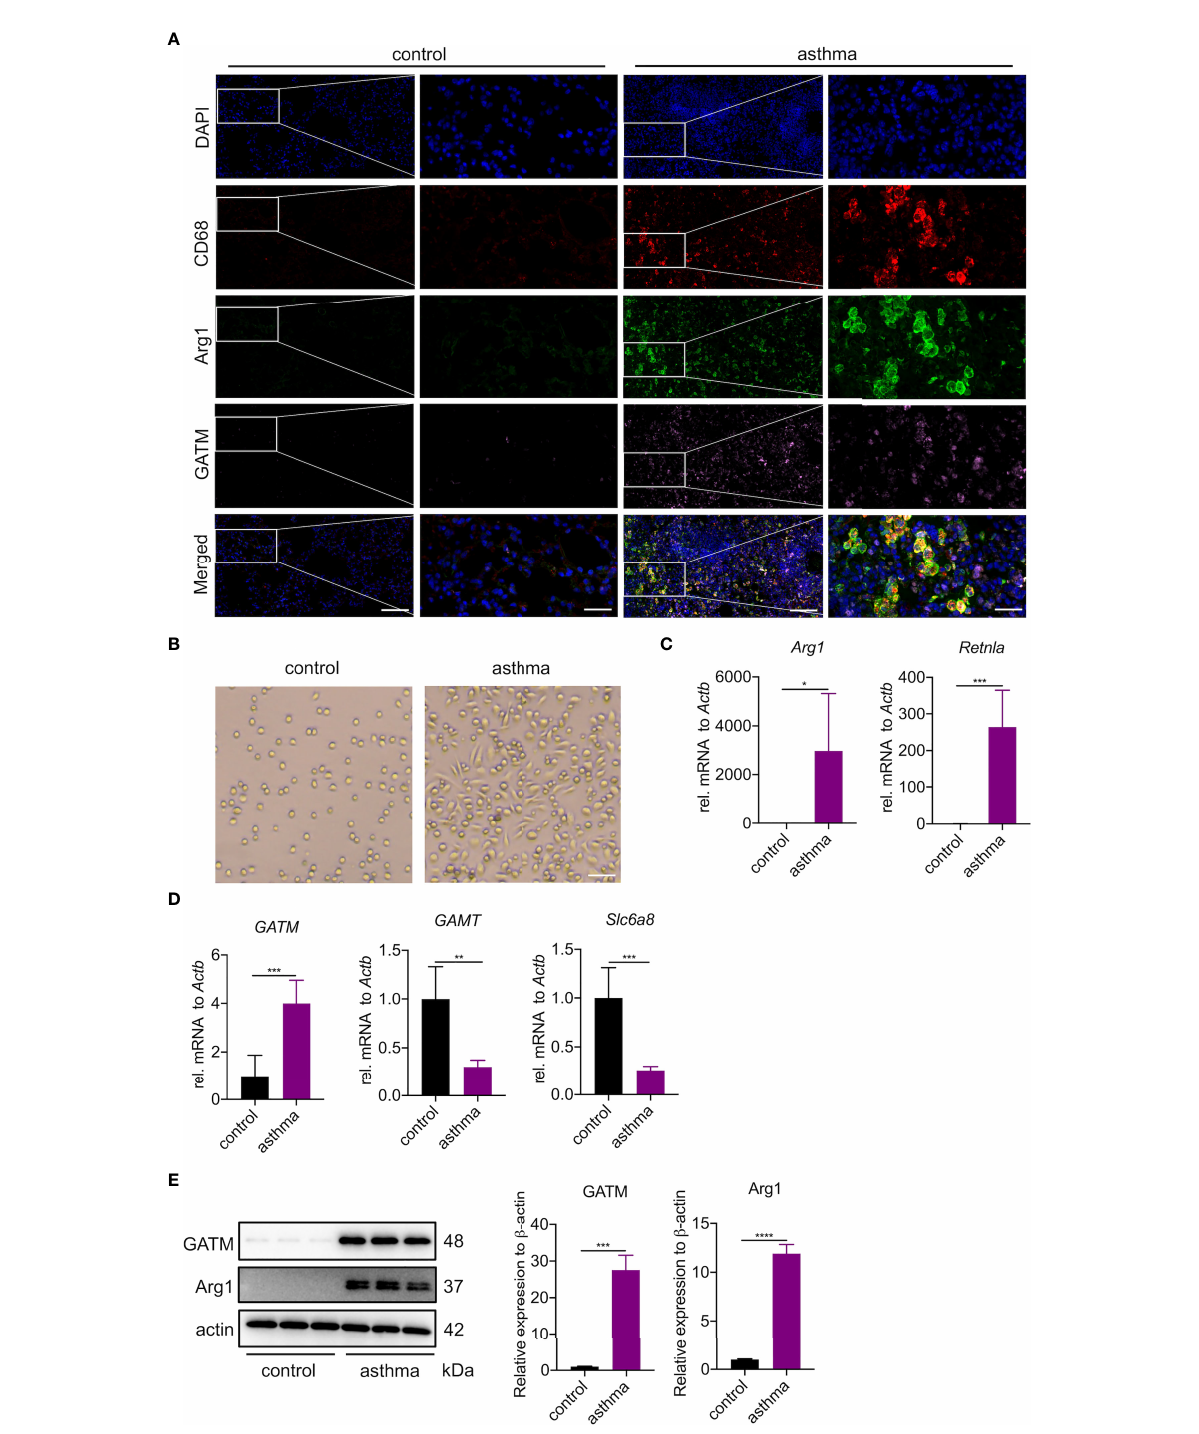
FIGURE 5 GATM is involved in the polarization of M2 type macrophages in asthma. (A) Immuno fl uorescence staining of CD68, Arg1 and GATM in lung tissue. Original magni fi cations x 200 left and x 630 right panel (n=4). Scale bar=20 uM. (B) Morphology of AMs under the microscope. Original magni fi cation x 100 (n=5). Scale bar=200 uM. (C) Transcription levels of Arg1 and Retnla in AMs were detected by quantitative PCR (n=5). (D) Transcription levels of GATM, GAMT and Slc6a8 in AMs were detected by quantitative PCR (n=5). (E) Arg1 and GATM expression levels in AMs were detected by western blotting (n=4). Data are expressed as mean ± SEM. Statistical signi fi cance was determined using t-tests; * P <0.05; ** P <0.01, *** P <0.001, **** P